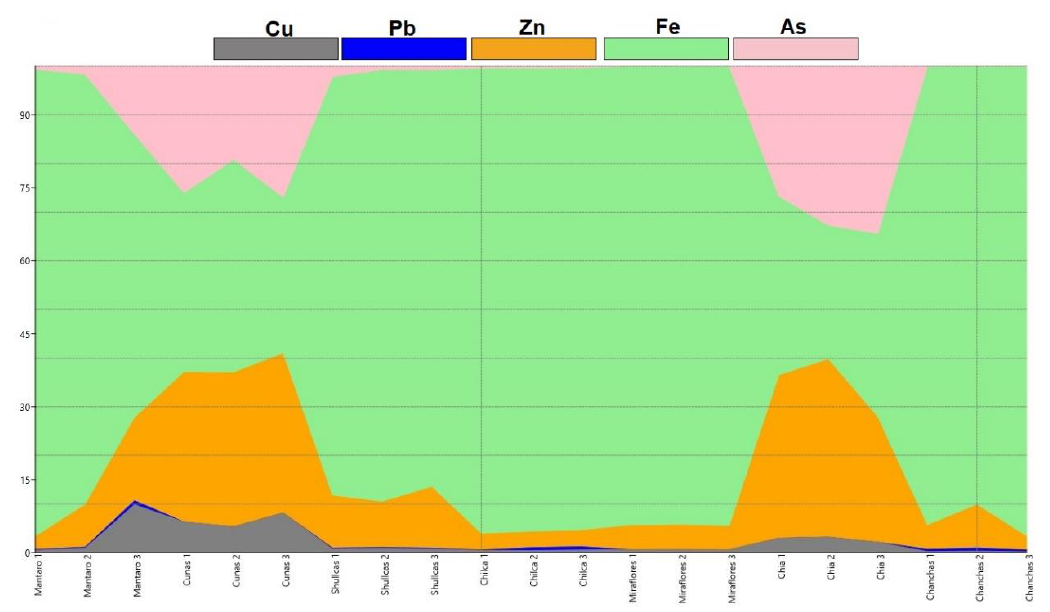
Figure 6. Distribution of the percentage contribution of heavy metals and arsenic by sampling site and river.